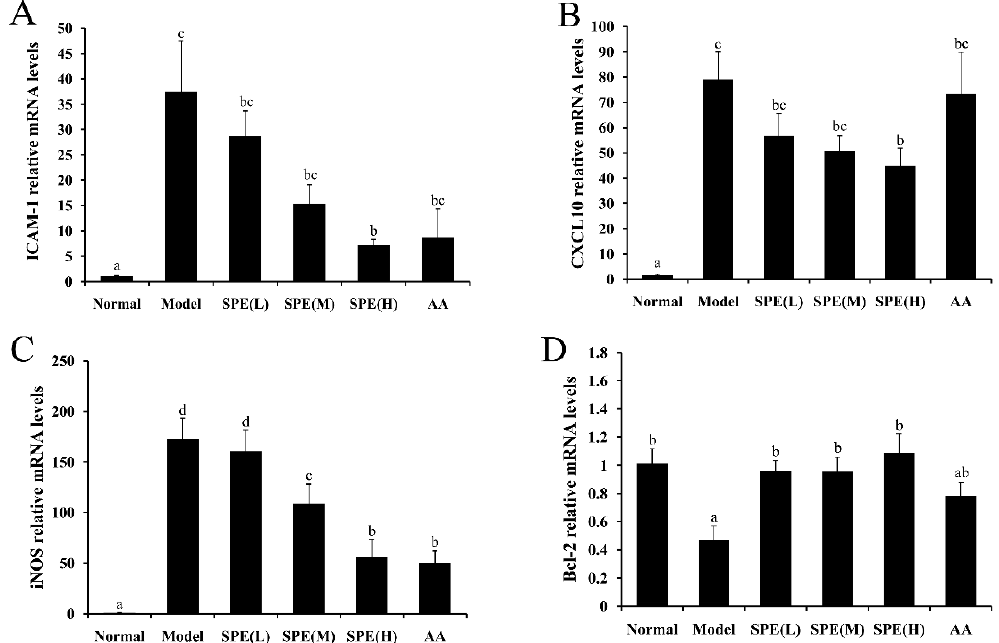
Figure 6. The effects of sheep placental extract (SPE) on the mRNA expression of ICAM-1 ( A ), CXCL10 ( B ), iNOS ( C ) and Bcl-2 ( D ) in liver tissues. The mRNA expression was normalised with the expression of β -actin in each sample. Values are represented as means ± SE (n = 11). a, b, c, d, ab and bc in the figures indicate statistically significant differences ( p < 0.05) among groups. The experimental groups pretreated with low dose SPE (5 mg/kg), medium dose SPE (10 mg/kg), high dose SPE (50 mg/kg) or the mixture of 18 amino acids equal to the 50 mg/kg SPE group are labelled as SPE (L), SPE (M), SPE (H) and AA, respectively.